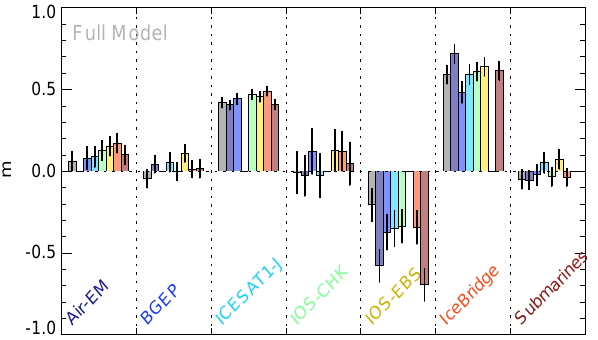
Figure 6. Coefficients of the ITRP indicator variables for fits that leave one data source out at a time for the Arctic Basin, 2000–2012. The coefficients for each source are grouped together. Grey bars show the coefficients for a fit that includes all of the observations, and bars in other colors indicate which source has been left out as shown by the colors of the diagonal labels (same order as the bars). The black lines give the 1 σ interval for the coefficients. ICESat-G is always the reference.